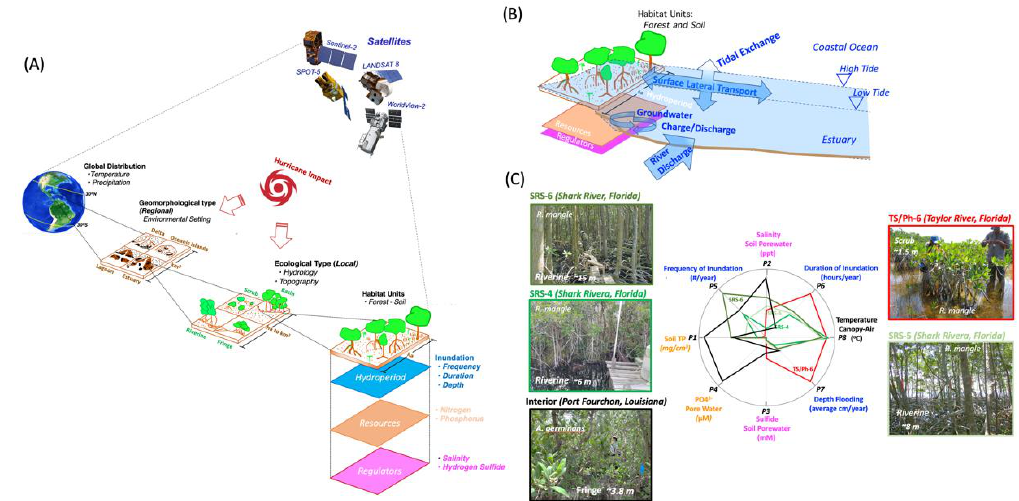
Figure 4. ( A ) Hierarchical classification for mangrove-dominated ecosystems describing abiotic controls (hydroperiod, resources, regulators) on mangrove structural and functional properties at the global (temperature, precipitation), regional (geomorphology, hurricanes), and local scale (ecotype habitats) (modified from [6,80]); remote sensing measurements are depicted to underscore the comprehensive information obtained about mangrove structural properties across these spatial scales and as shown by the high frequency of publications (see Figure 1); ( B ) main hydrological factors (tidal, groundwater, river discharge) regulating the hydroperiod and hydrological connectivity between the forest and adjacent coastal waters; ( C ) radar graph showing the relative role of each hydroperiod, resources and regulators components in the configuration of a eight-dimensional hypervolume “niche” for different mangrove ecotypes (Riverine, Fringe, Scrub) in tropical savanna (Everglades, FL, USA [43]) and humid subtropical (Port Fourchon, LA, USA [81]) climates; the shape of the niche defines the mangrove wetland net primary productivity and structural properties (e.g., canopy height) (Rivera-Monroy et al. unpublished results). For easier identification, notice that the color highlighted in the picture frame in panel ( C ) corresponds to the same color as the niche spaces outlined inside the